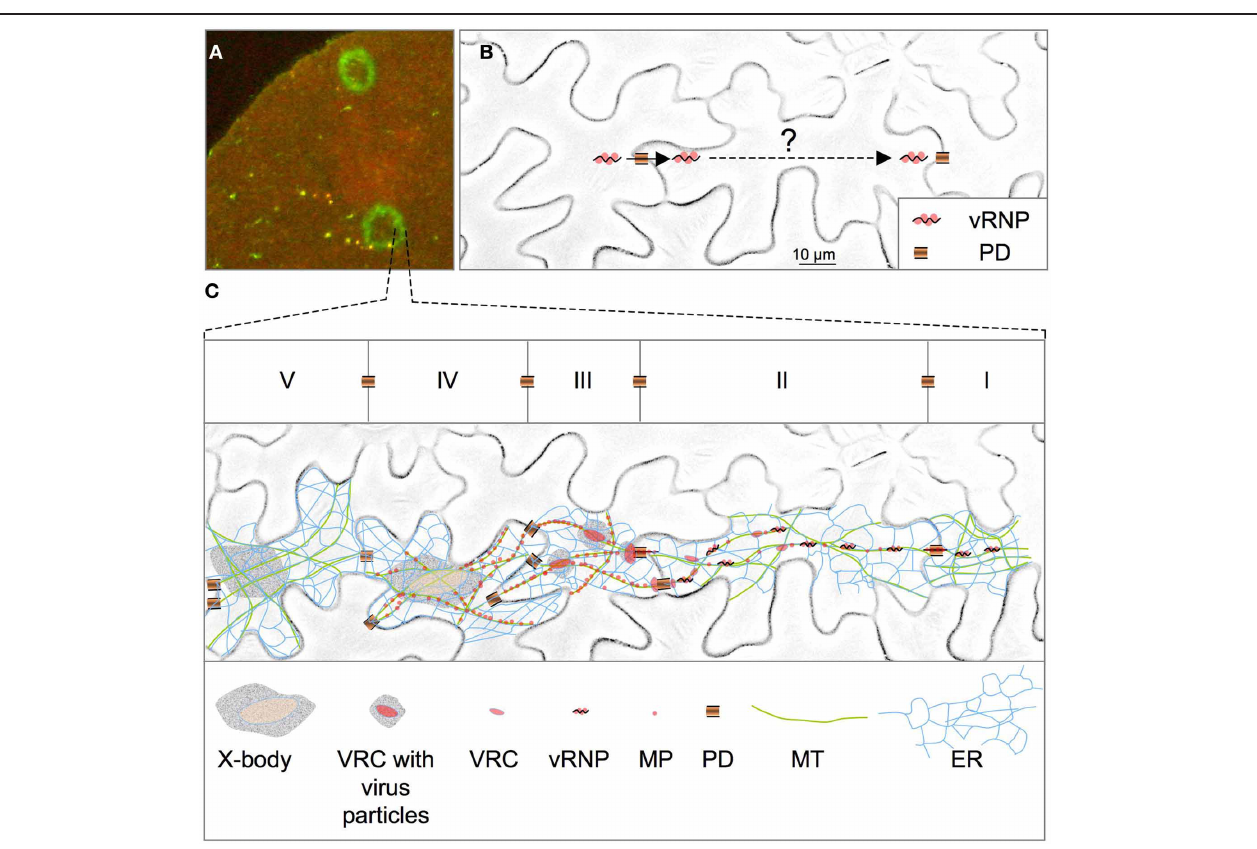
FIGURE 1 | Spreading of TMV infection. (A) Section of a Nicotiana benthamiana leaf showing infection sites of TMV-MP:GFP at 5 days post-infection. The outer rim of the infection site represents the leading front of the spreading virus. The infection site appears as a fluorescent ring because MP:GFP accumulates only transiently and is then degraded. (B) Upon entering a cell through plasmodesmata (PD) the vRNP must be replicated and transported across the diameter of the cell before it can infect the next cell. N. benthamiana epidermal cells are shown. (C) Current model for TMV movement and the transient activities of the MP during this process. The model is projected on the pattern of five epidermal cells (depicted as I–V) at the leading front of infection. Infection of a cell (II) starts with the association of the vRNP with sites on the ER that concur